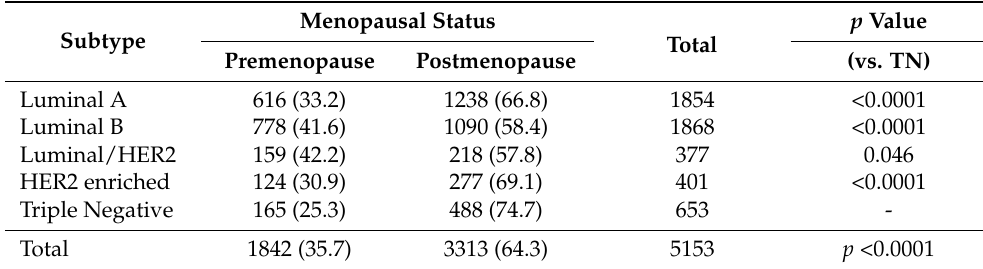
Table 1. Breast Cancer Subtypes and Menopausal